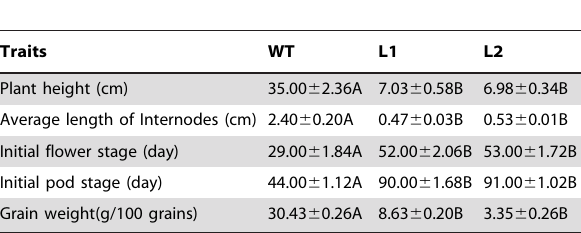
Table 1. Characterization of transgenic and WT soybean